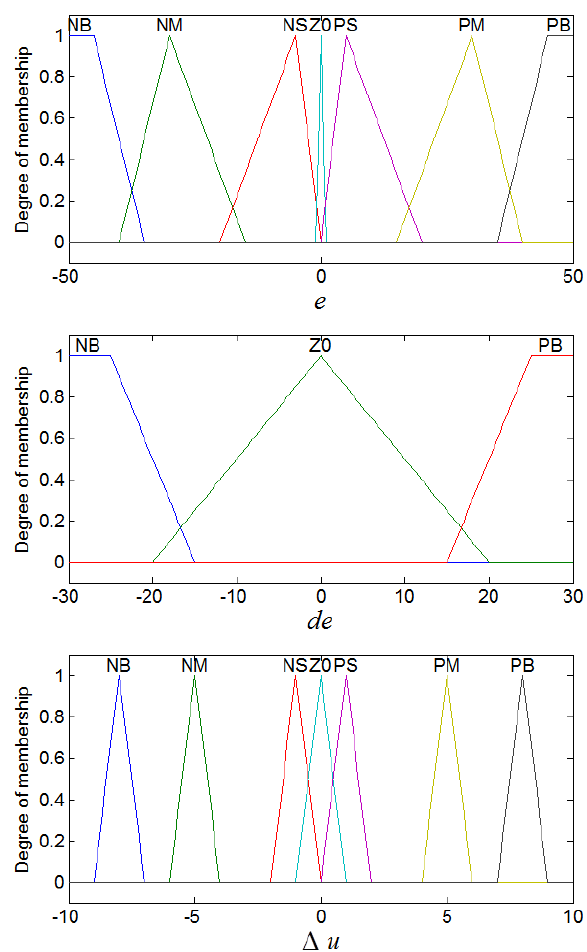
Figure 8. Input and output membership